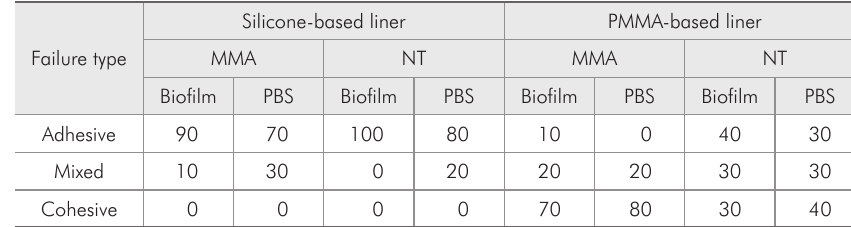
Table 2 - Failure distribution ( % ) for liner-PMMA